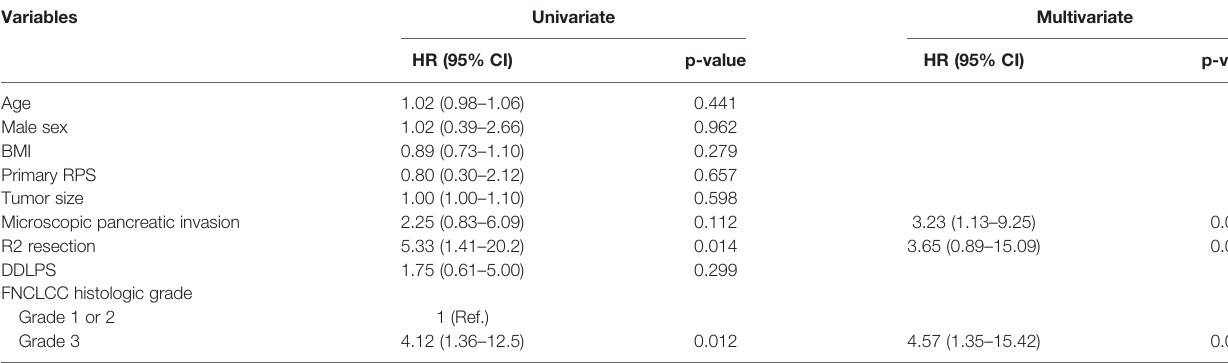
TABLE 3 | Univariate and multivariate analyses of risk factors associated with local recurrence in patients who underwent